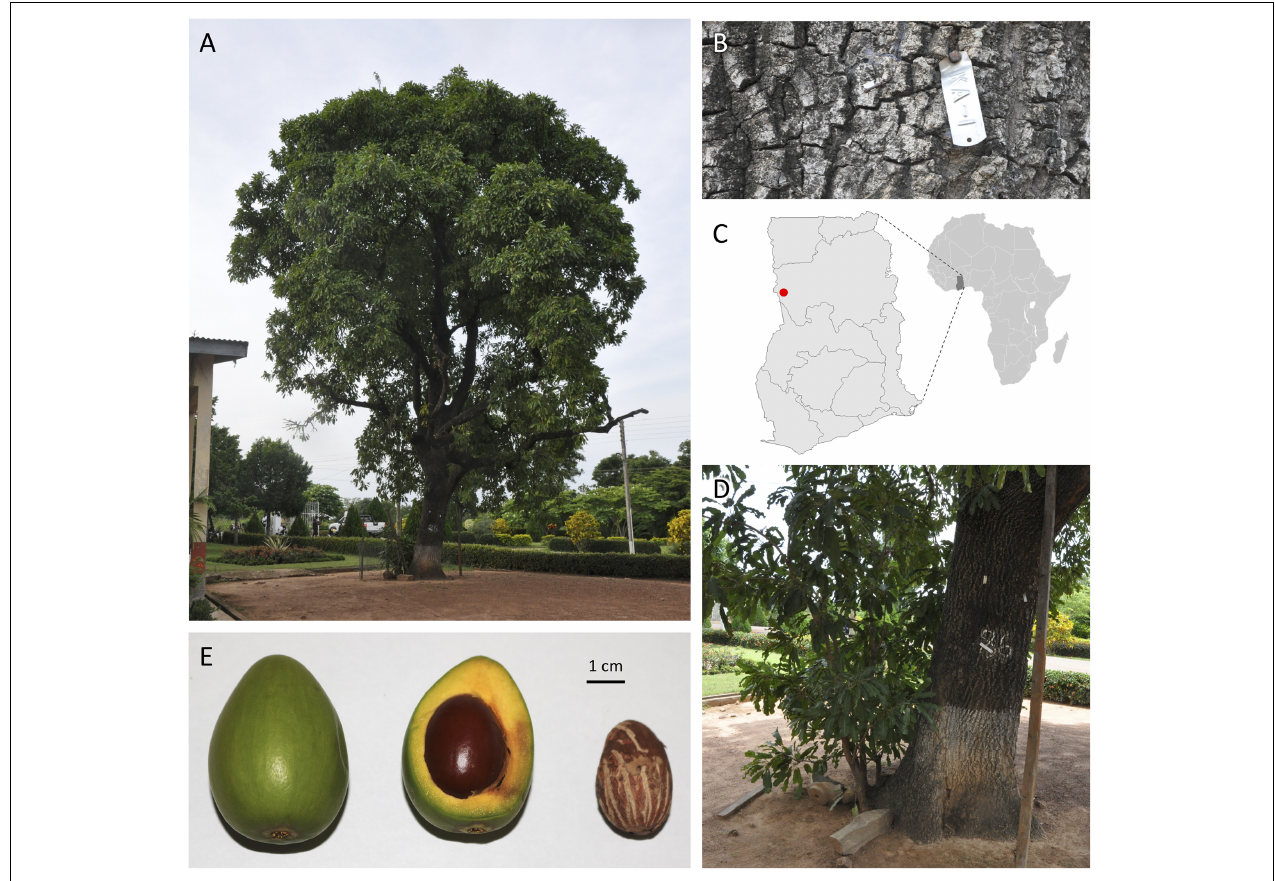
FIGURE 1 | Vitellaria paradoxa reference accession ‘KA01’ is a giant-type shea tree (A,B) found on the CRIG research substation in Bole in northwestern Ghana ( C , red dot). For such an aged tree, aggressive root-pruning (D) was required to stimulate the production of leaf tissue conducive to high-quality gDNA extraction appropriate for long-read sequencing. (E) A typical whole fruit (left), fresh cross-section (middle), and dried kernel (right) from this accession.